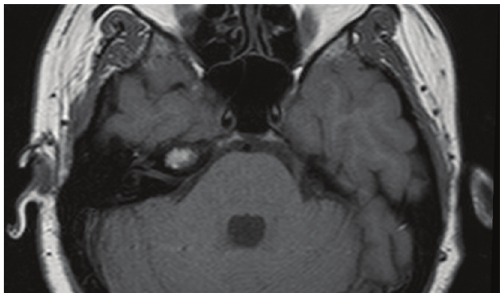
Figure 3: Axial T1-weighted image with Gadolinium showes the absence of postcontrast enhancement in the lesion of the right petrous apex.